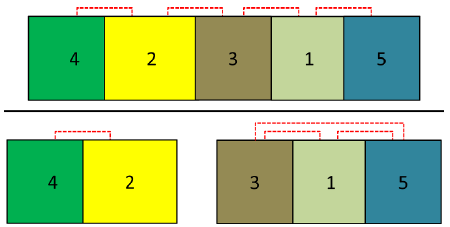
Figure 4. Cluster with continuous arrangement (top) and one of disconnected datasets (bottom)